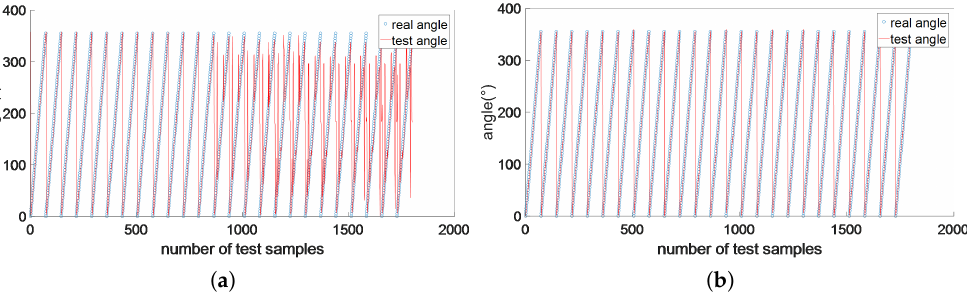
Figure 9. Comparison of the test angle and actual angle of the model before and after transfer learning. ( a ) Before transfer learning. ( b ) After transfer learning.